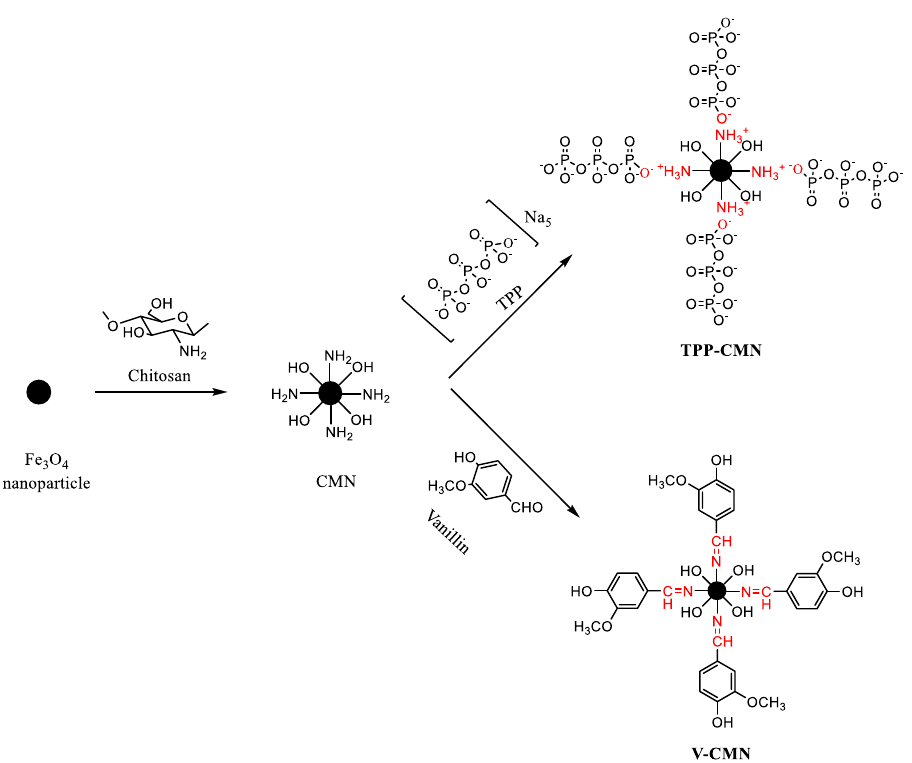
Figure 1. The synthesis route for the production of TPP-CMN and V-CMN nano-sorbents and their adsorption mechanism of heavy